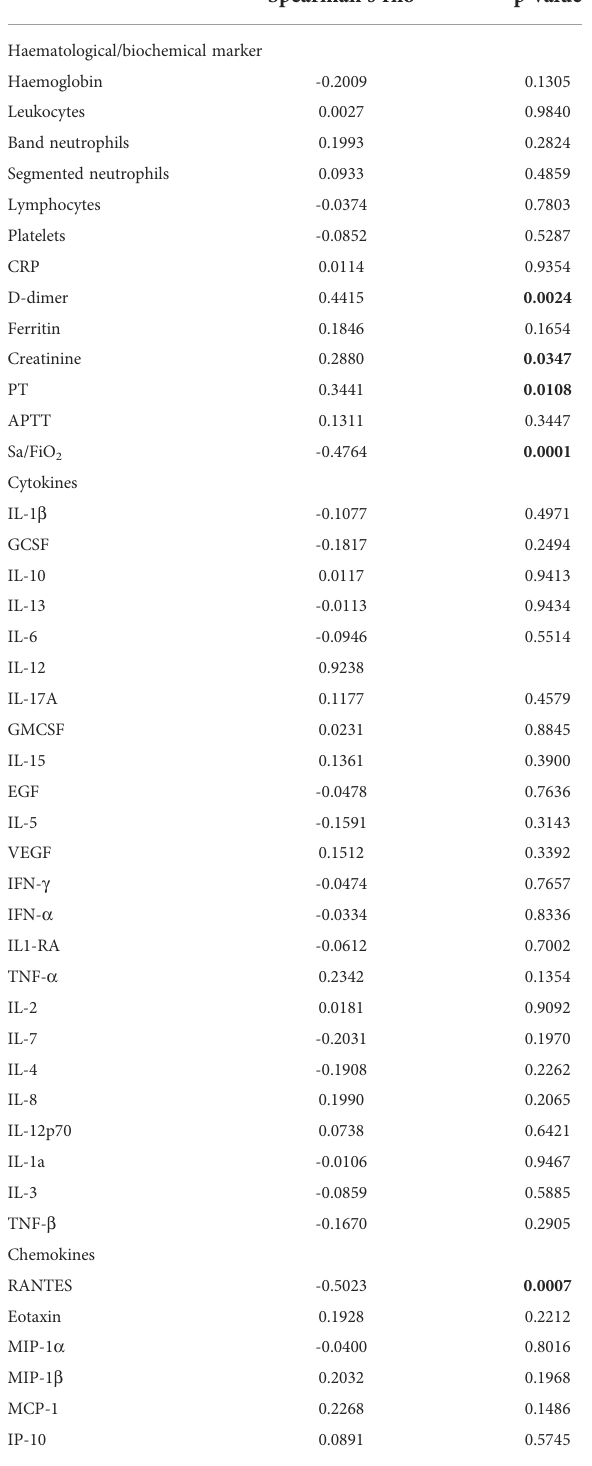
TABLE 3 Correlations between zonulin levels and haematological / biochemical markers and cytokines/chemokines at